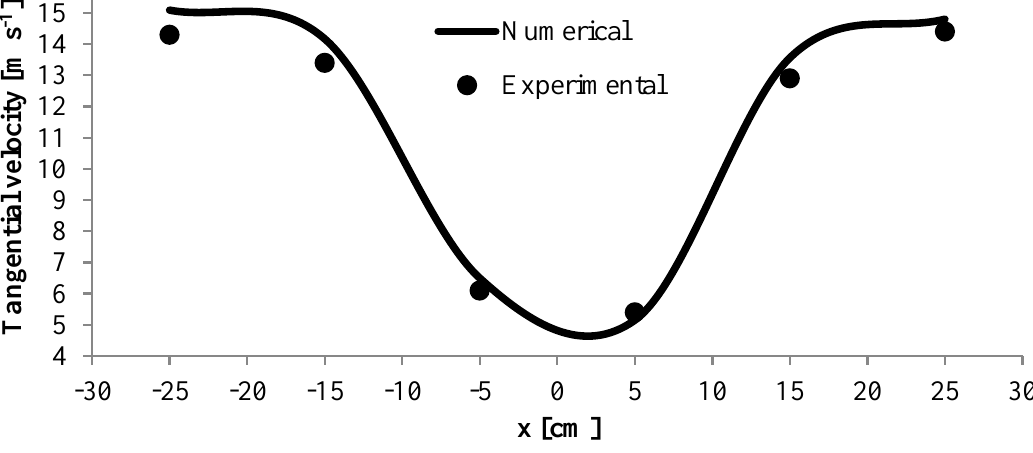
Figure 5. Validation between numerical results and experimental data for tangential velocity.